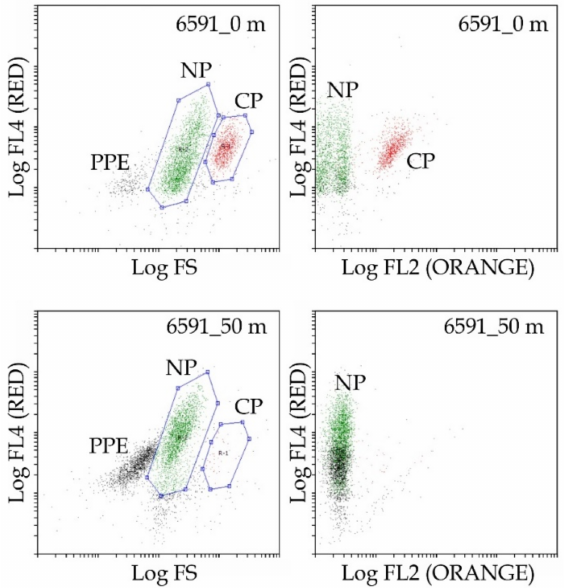
Figure 3. Gating cryptophytes (CP), other nanophytoplankton (NP) and photosynthetic picoeukary- otes (PPE) in the space of forward light scattering (FS is cell size), red autofluorescence (FL4 is Chl- a ) and orange autofluorescence (FL2 is phycoerythrin) in two samples (station 6591 at 0 and 50